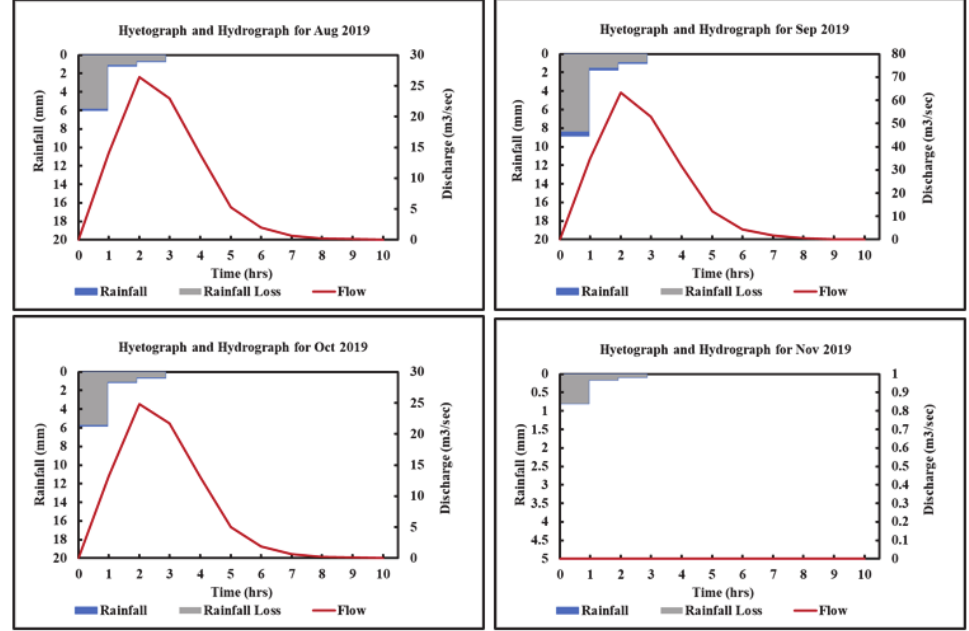
Figure 18. Hyetograph and hydrograph for maximum daily rainfall in August, September, October, and November 2019.